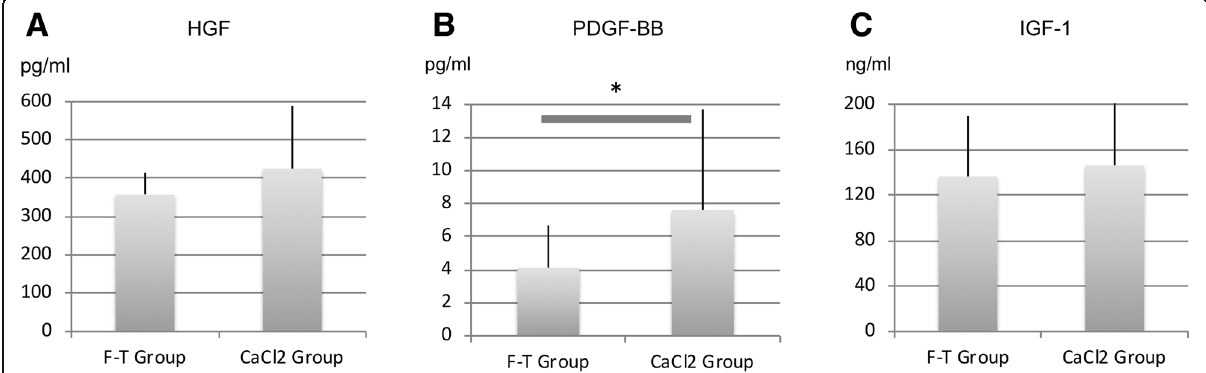
Fig. 5 Concentrations of ( a ) HGF, ( b ) PDGF-BB, and ( c ) IGF-1 in the PRP samples. PDGF-BB levels were significant higher in the CaCl 2 group ( p